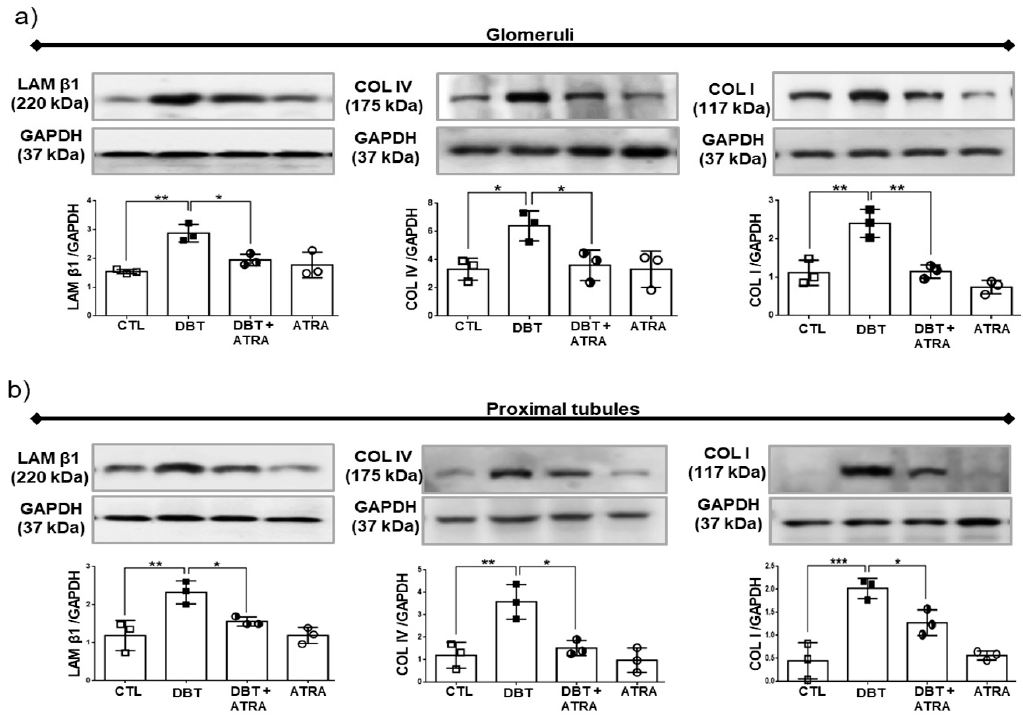
Figure 5. All-trans retinoic acid (ATRA) attenuated renal fibrogenesis in a rat model of diabetic nephropathy (DN). Western blot and densitometric analysis of Laminin beta 1 (LAM β 1), Collagen IV (COL IV) and Collagen I (COL I) in ( a ) isolated glomeruli and ( b ) isolated proximal tubules. Laminin